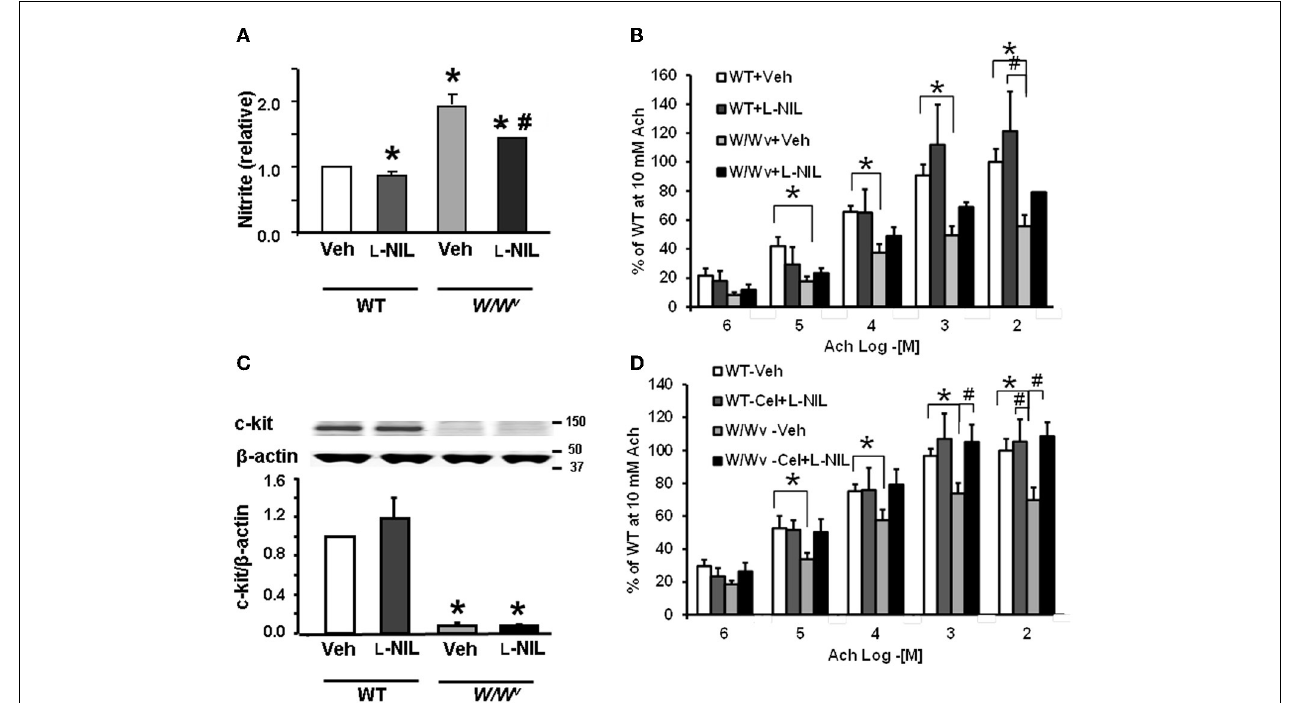
FIGURE 5 | Effect of i.p. treatment with L-NIL or L-NIL + celecoxib on fundus nitrite levels, smooth muscle reactivity to Ach and c-kit expression. (A) Bar graph showing the effects of L-NIL treatment for 3 days on the average nitrite levels relative to that in Wt vehicle mice. Nitrite levels were significantly elevated in W/W v mice compared to Wt but were significantly reduced in W/W v and wild type mice by L-NIL treatment ( ∗ p < 0 . 05 vs. wild type + vehicle; # p < 0 . 05 vs. W/W v + vehicle). (B) Bar graph showing the effects of L-NIL treatment on fundus muscle sensitivity to acetylcholine (Ach). The reactivity to Ach was suppressed in W/W v vs. the wild-type mice.